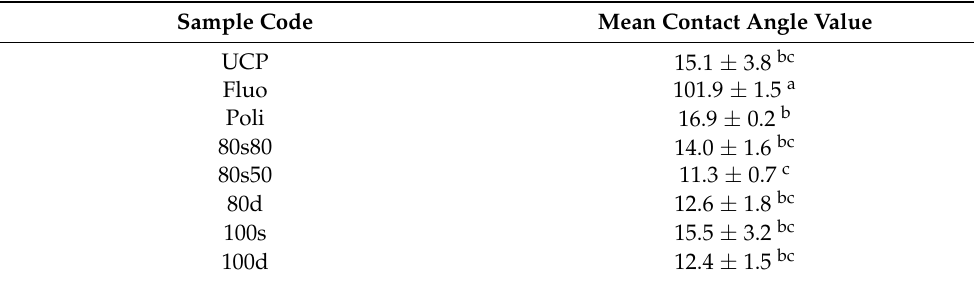
Table 4. Oil contact angle values of first set